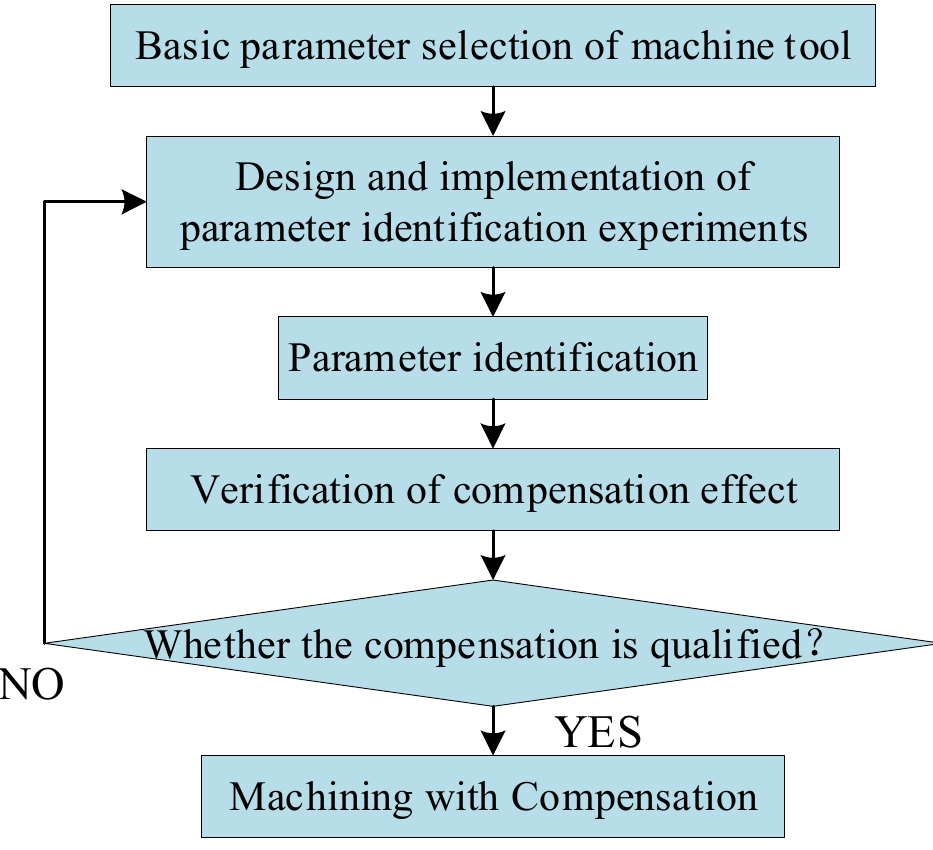
Figure 6. Thermal error compensation